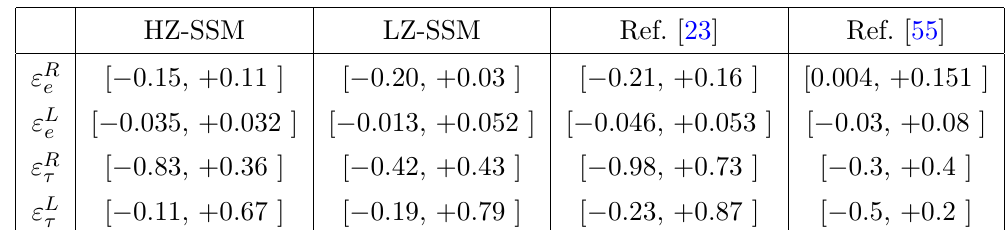
Table 2 . The (cid:12)rst column shows the limits on the (cid:13)avor-diagonal NSI parameters " R " L as obtained in the present work using the Borexino Phase-II data and considering HZ-SSM for (cid:28) the neutrino (cid:13)uxes. The second column displays the same considering LZ-SSM. These constraints are obtained varying only one NSI parameter at-a-time, while the remaining three NSI parameters are (cid:12)xed to zero. The third column contains the bounds using Borexino Phase-I results as obtained in ref. [23] (for HZ-SSM case only). For the sake of comparison, we present the global bounds from ref. [55] in the forth column. All limits are 90% C.L. (1